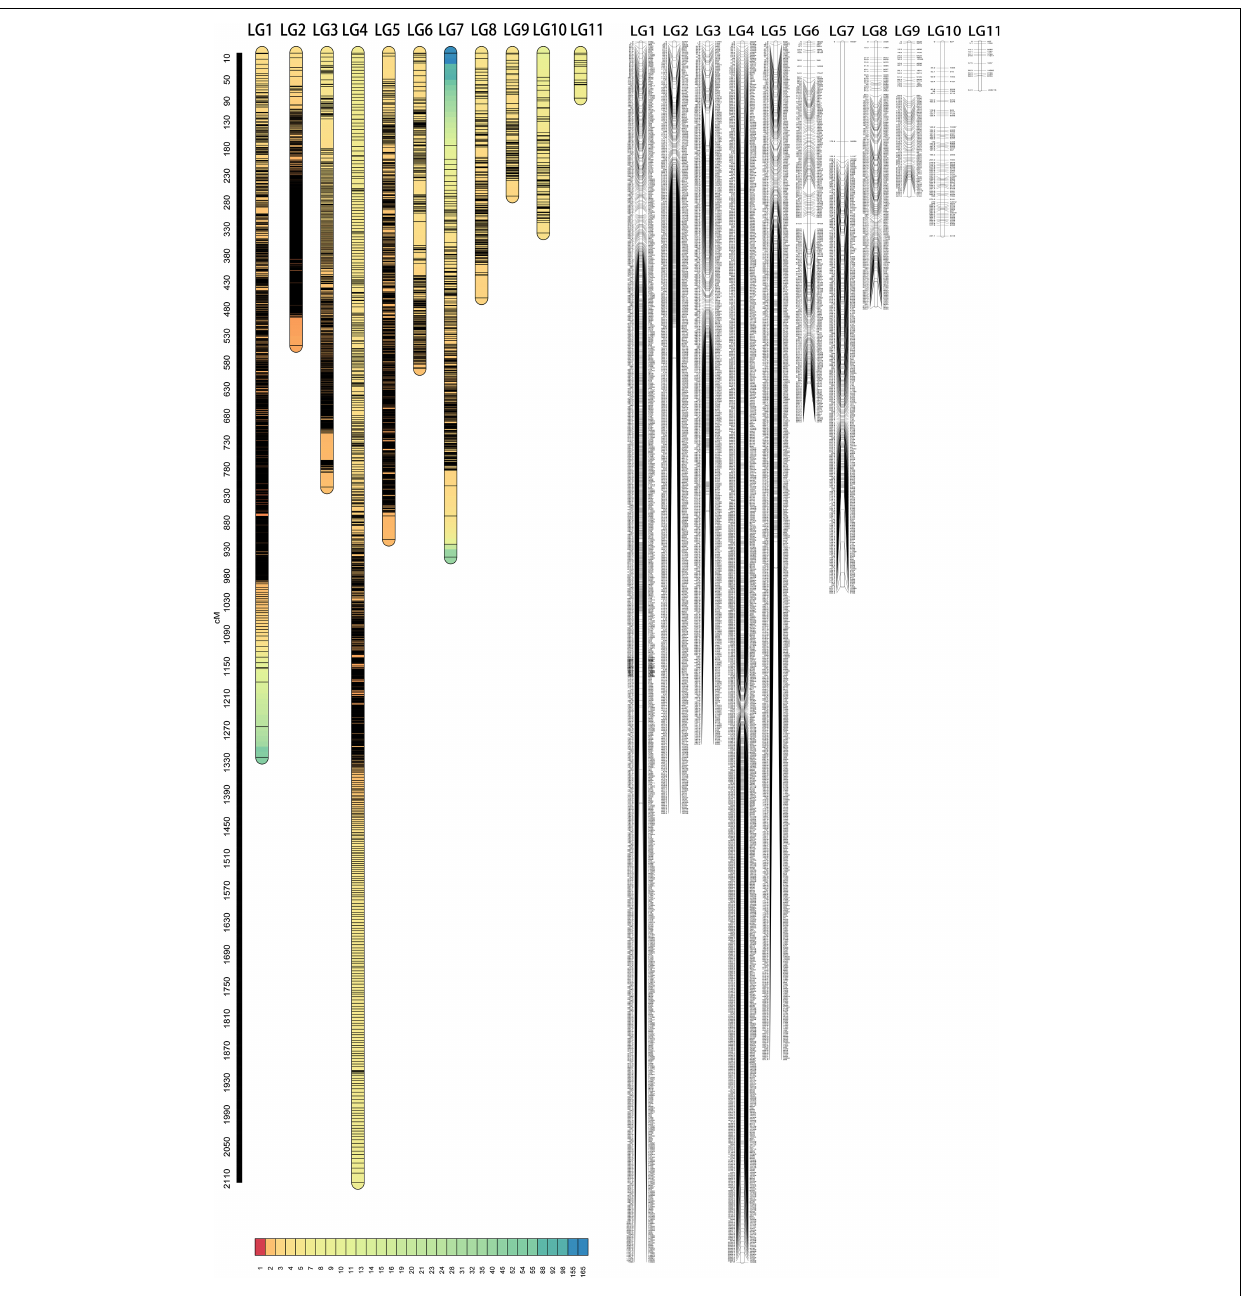
FIGURE 1 | The marker density map (left) and linkage map (right) of T. grandis composed of 11 linkage groups